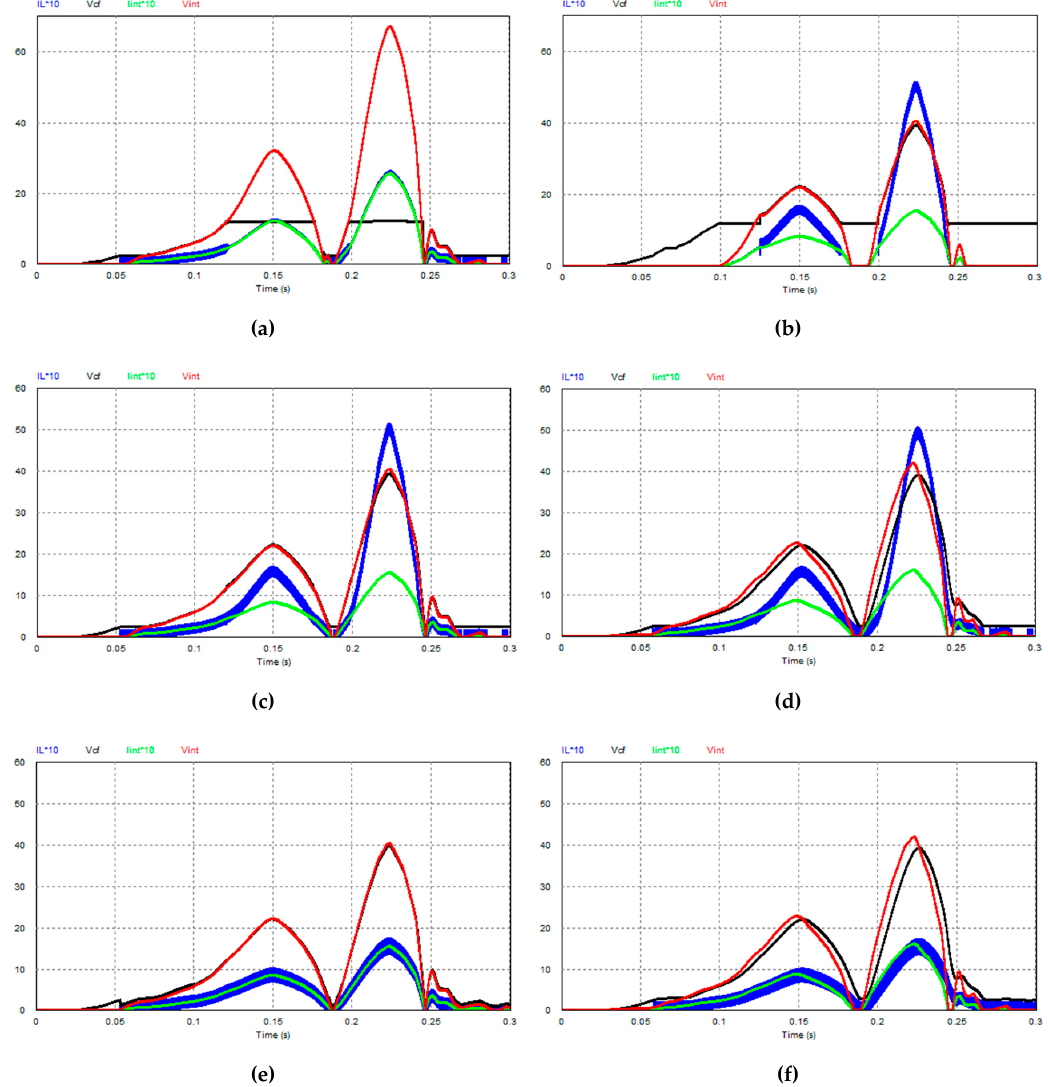
Figure 19. PSIM simulations with a pulse input: ( a ) HBB boost mode C f = 10 μ F, ( b ) HBB buck mode C f = 10 μ F, ( c ) HBB C f = 10 μ F, ( d ) HBB C f = 200 μ F, ( e ) Sepic C f = 10 μ F, ( f ) Sepic C f = 200 μ